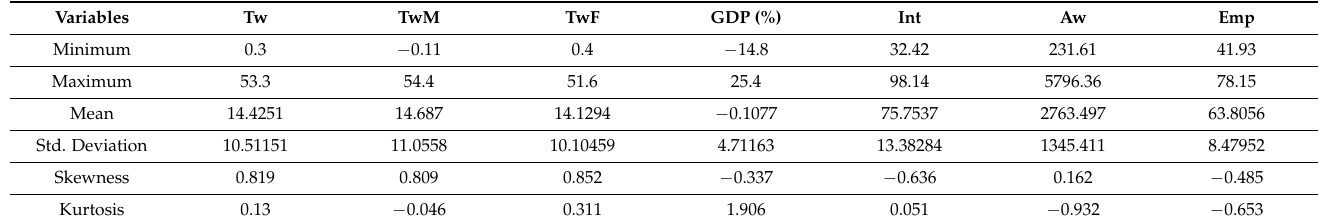
Table 2. Summary statistics for the interest variables.